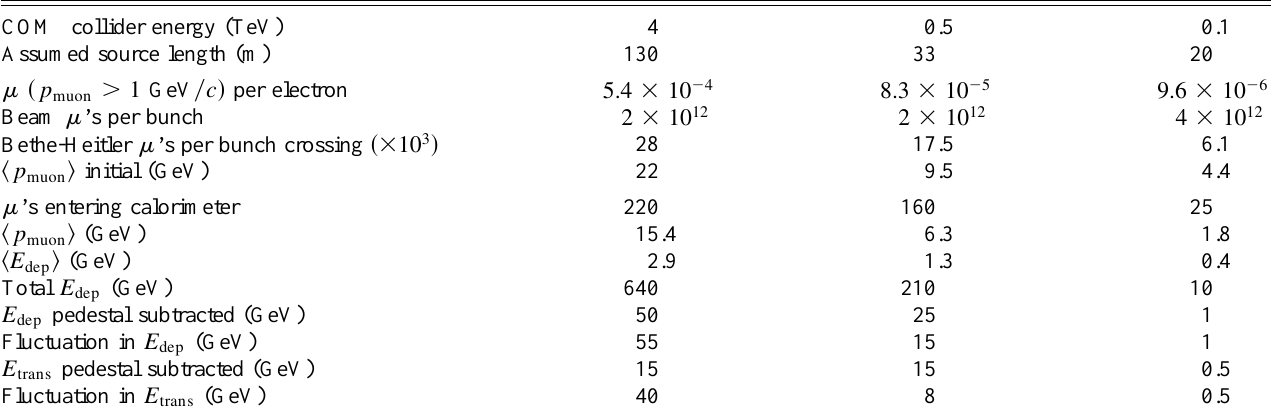
TABLE XVII. Bethe-Heitler